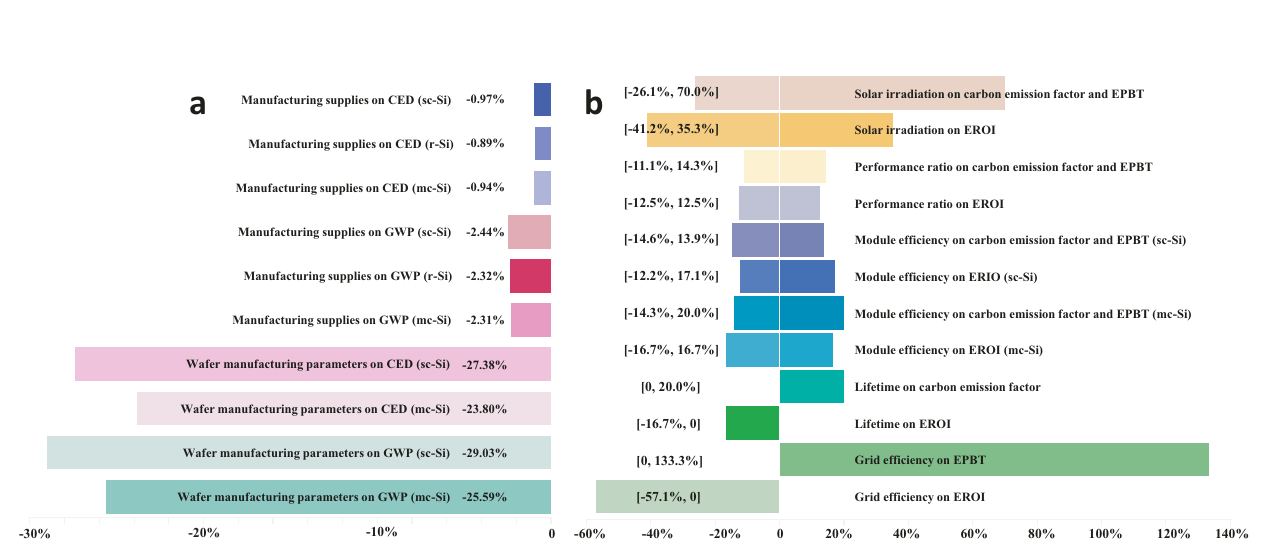
trading partners) and wafer manufacturing parameters on cumulative energy demand (CED) and global warming potential (GWP), ( b ) solar irradiation, perfor- mance ratio, module ef fi ciency, lifetime, and grid ef fi ciency on energy payback time (EPBT), carbon emission factor, and energy return on investment (EROI).